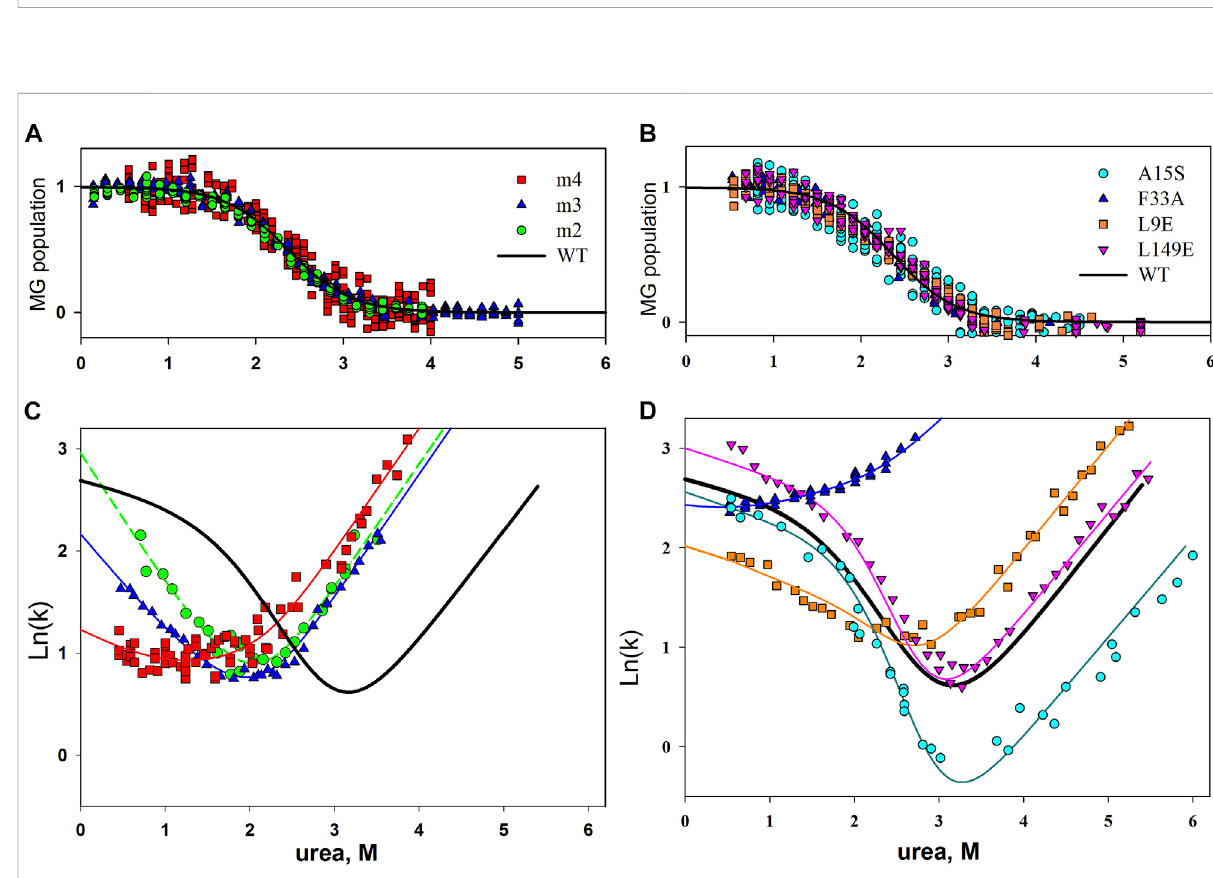
FIGURE 2 (A , C) Plot of molten globule state population versus urea concentration for wild-type and mutant apomyoglobin. (B , D) Chevron plots of wild- type apomyoglobin and its mutant form. Experimentally obtained data for mutant forms of the protein are shown by symbols; the approximation of these data with a use of parameters assuming that the substitution did not change the stability of the molten globule state is shown by lines. m2, m3 and m4, simultaneous substitution of two, three and four amino acids; m2, A15S, A19S; m3, A15S, A19S, V21T; m4, L9D, A15S, A19S,